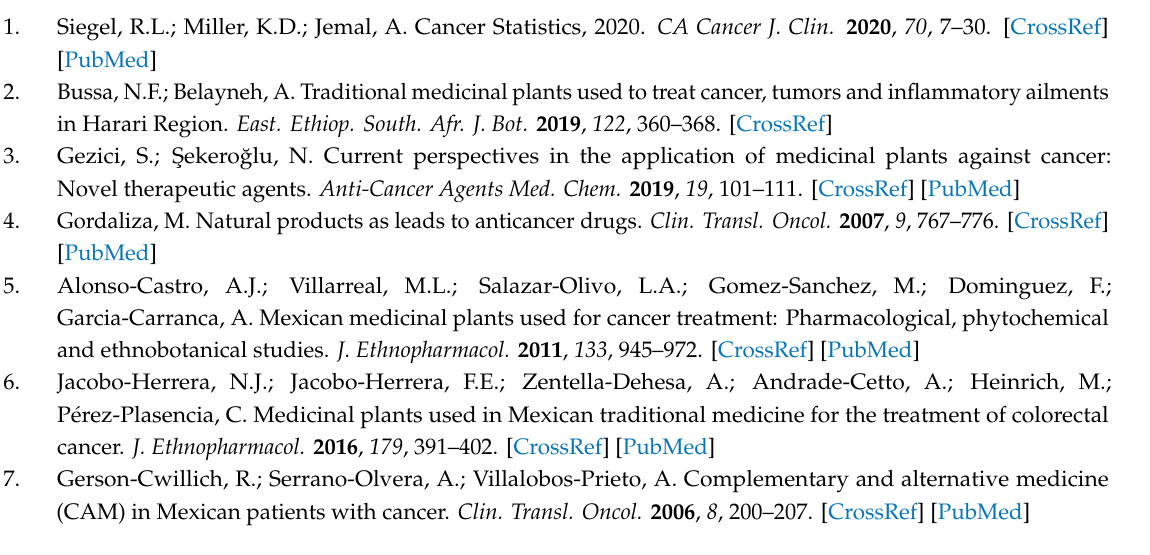
Supplementary Materials: The following are available online, Figure S1: 1 H-NMR spectrum of phyllocladan-16 α , 19-diol ( 1 ); Figure S2: 13 C-NMR spectrum of phyllocladan-16 α ,19-diol ( 1 ); Figure S3: APT experiment spectrum of phyllocladan-16 α ,19-diol ( 1 ); Figure S4: 1 H- 1 H COSY spectrum of phyllocladan-16 α ,19-diol ( 1 ); Figure S5: HSQC spectrum of phyllocladan-16 α ,19-diol ( 1 ); Figure S6: HSQC spectrum of phyllocladan-16 α ,19-diol ( 1 ); Figure S7: 1 H-NMR spectrum of phyllocladan-16 α -ol ( 2 ); Figure S8: APT experiment spectrum of phyllocladan-16 α -ol ( 2 ); Figure S9: 1 H- 1 H COSY spectrum of phyllocladan-16 α -ol ( 2 ); Figure S10: 1 H-NMR spectrumofphylloclad-16-en-3-ol( 3 ); FigureS11: APTexperimentspectrumofphylloclad-16-en-3-ol( 3 ); FigureS12: 1 H- 1 H COSY spectrum of phylloclad-16-en-3-ol ( 3 ); Figure S14: HSQC spectrum of phylloclad-16-en-3-ol ( 3